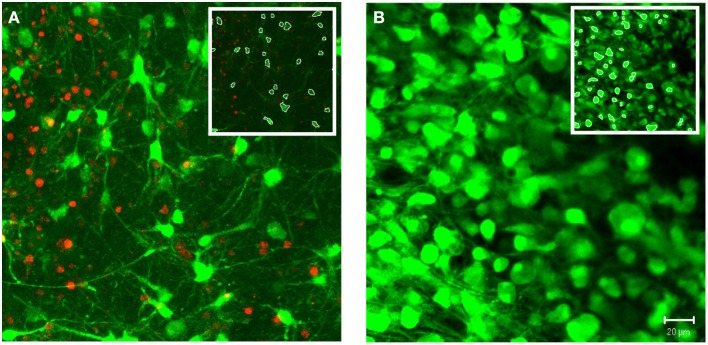
Demonstration of system robustness: soma segmentation in
ex vivo
brain tissue. Custom 3-D segmentation algorithms were applied to z-stacks attained from confocal imaging of brain slices from cerebral cortex. The z-stacks tested varied based on the density of viable cells, ranging from relatively low (A) to high (B) densities. Following the same protocol of the in vitro testing, the algorithms achieved accuracies of 93% (A) and 97% (B) (α = 50, β = 0.15, TA = 60%, TB = 95%). Images were taken at 40×. (Inset) White pixels indicate soma boundaries for a single slice within the z-stack. Scale bar = 20 μm.